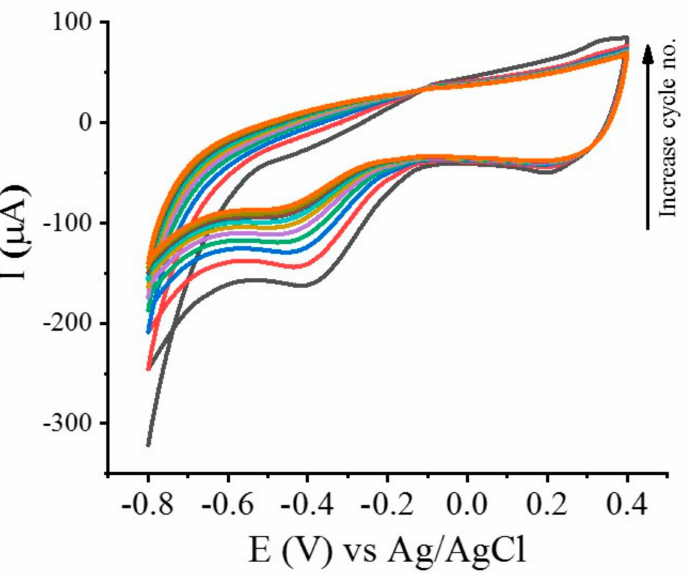
Figure 2. CV of the electropolymerization of sol-gel MIP on fMWCNT/ITO electrode at a scan rate of 50